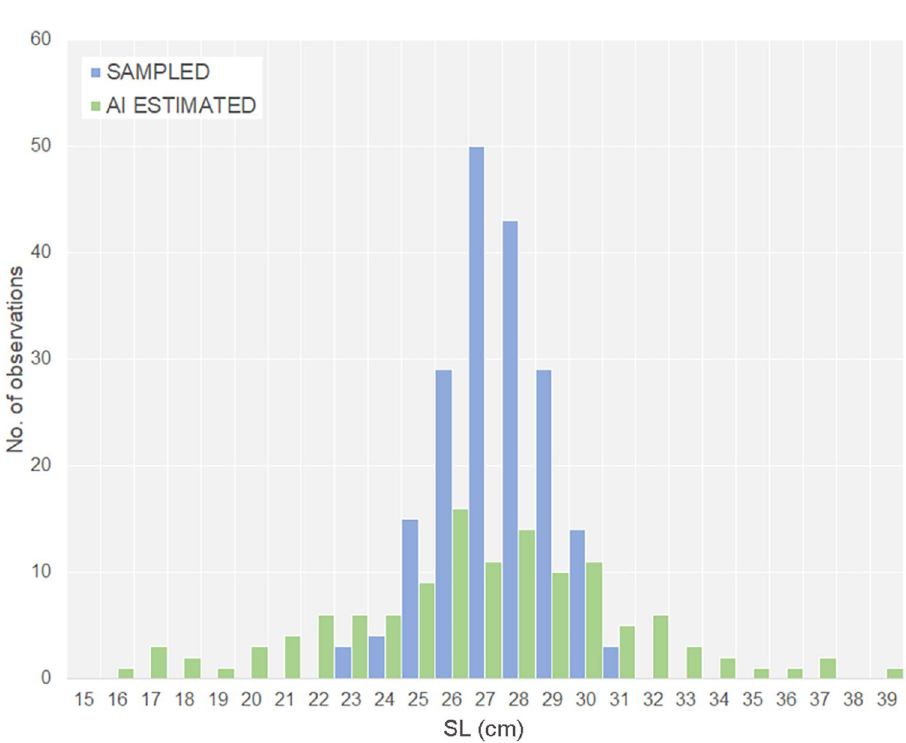
Figure 2. Standard-length histograms for sampled versus AI estimated distributions (Source: R version